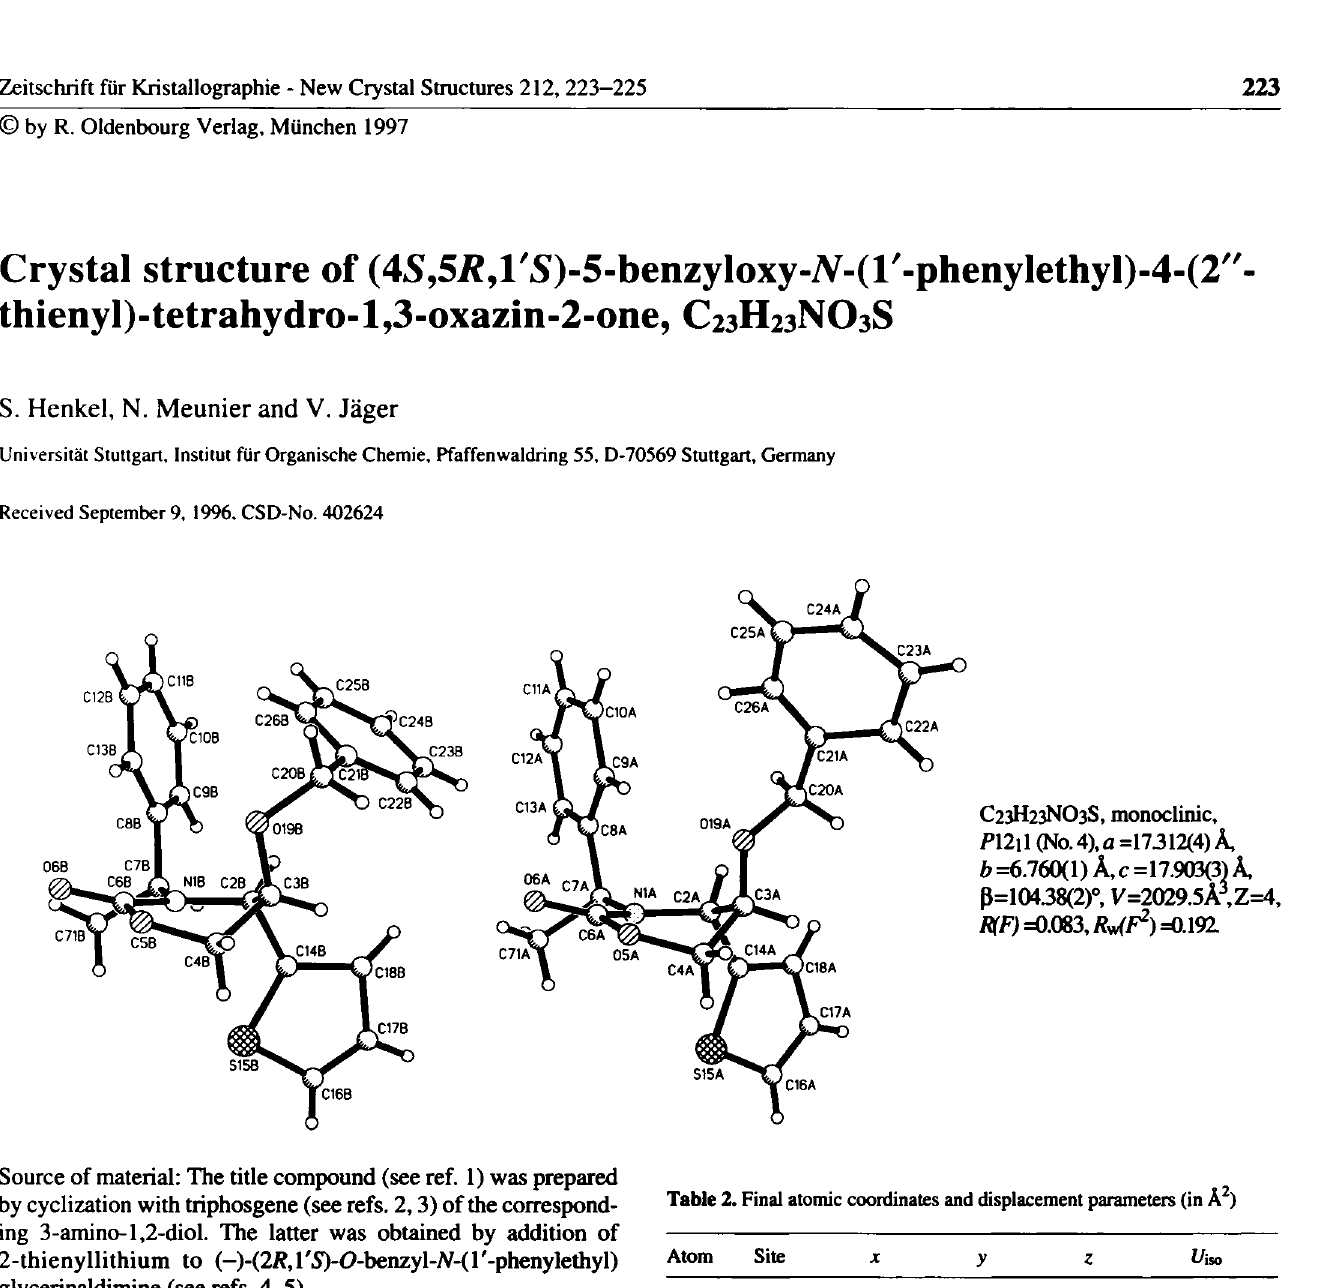
Table 1. Parameters used for the X-ray data collection